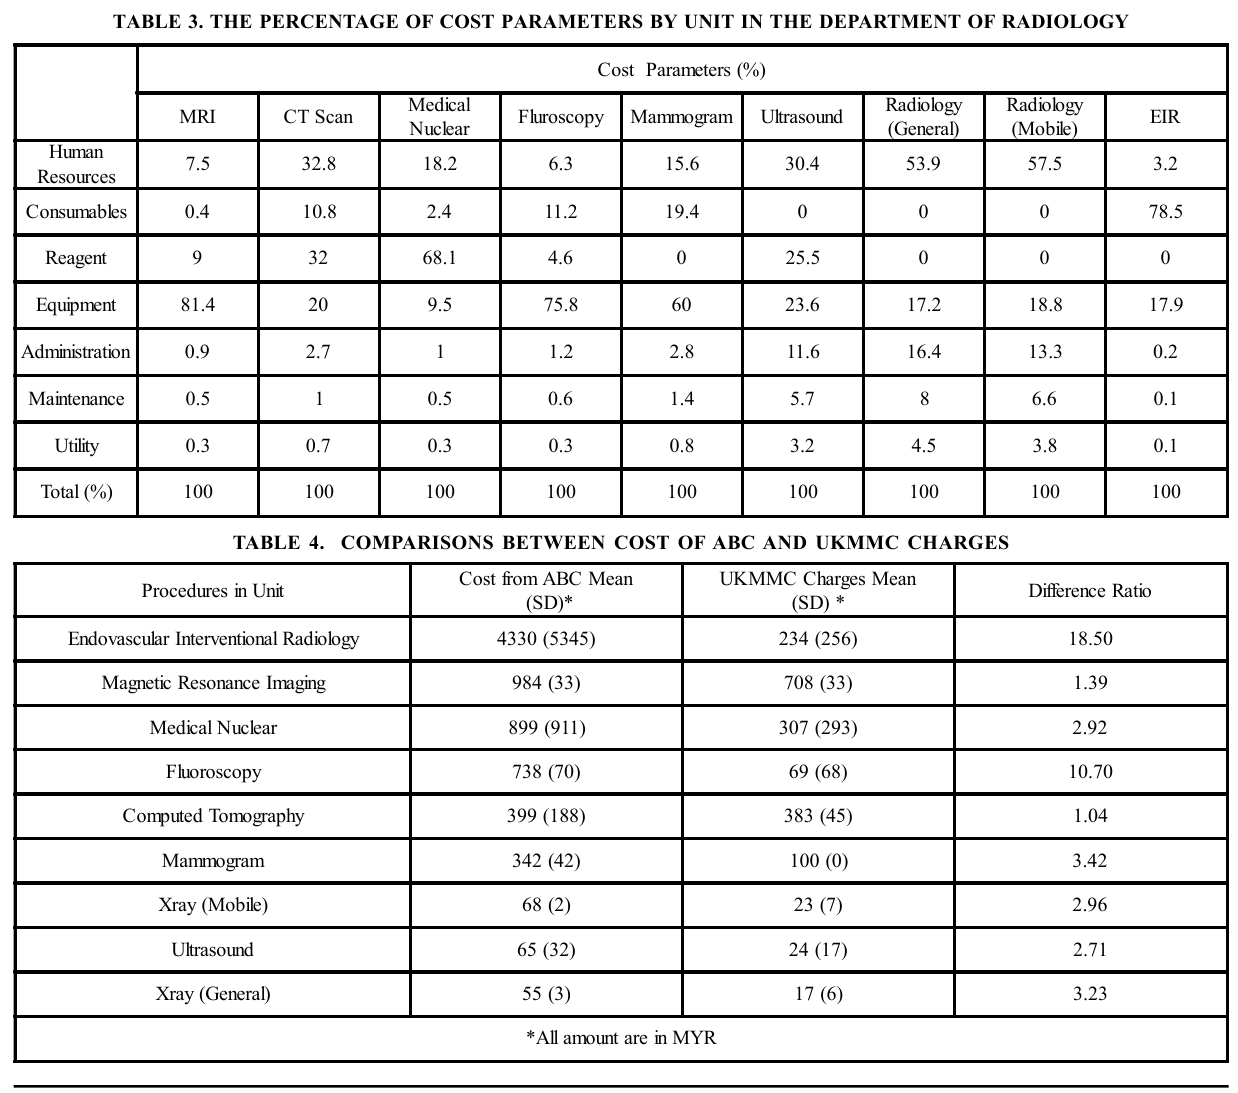
TABLE 3. THE PERCENTAGE OF COST PARAMETERS BY UNIT IN THE DEPARTMENT OF